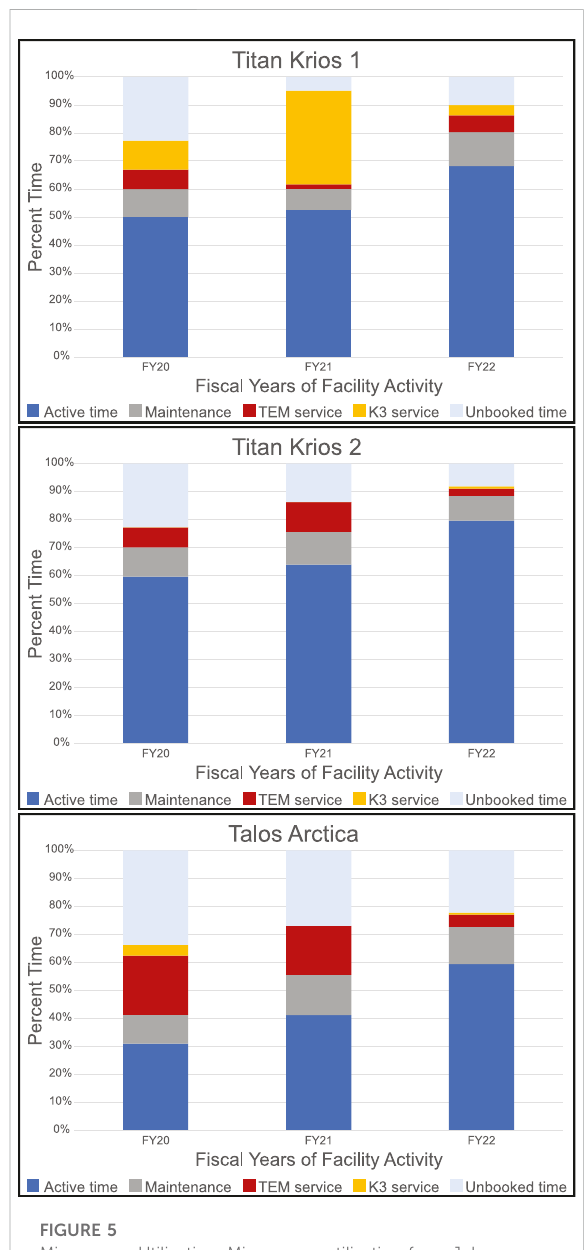
FIGURE 5 Microscope Utilization. Microscope utilization from July 2019 through June 2022 broken down by fi scal year (July to June) for each microscope. Active time is user sessions and staff collaborative work. Maintenance includes cryo-cycles and preventative maintenance by staff and service engineers for all equipment. Service time required a Thermo Fisher Scienti fi c or Gatan service engineer to intervene as the microscope was not